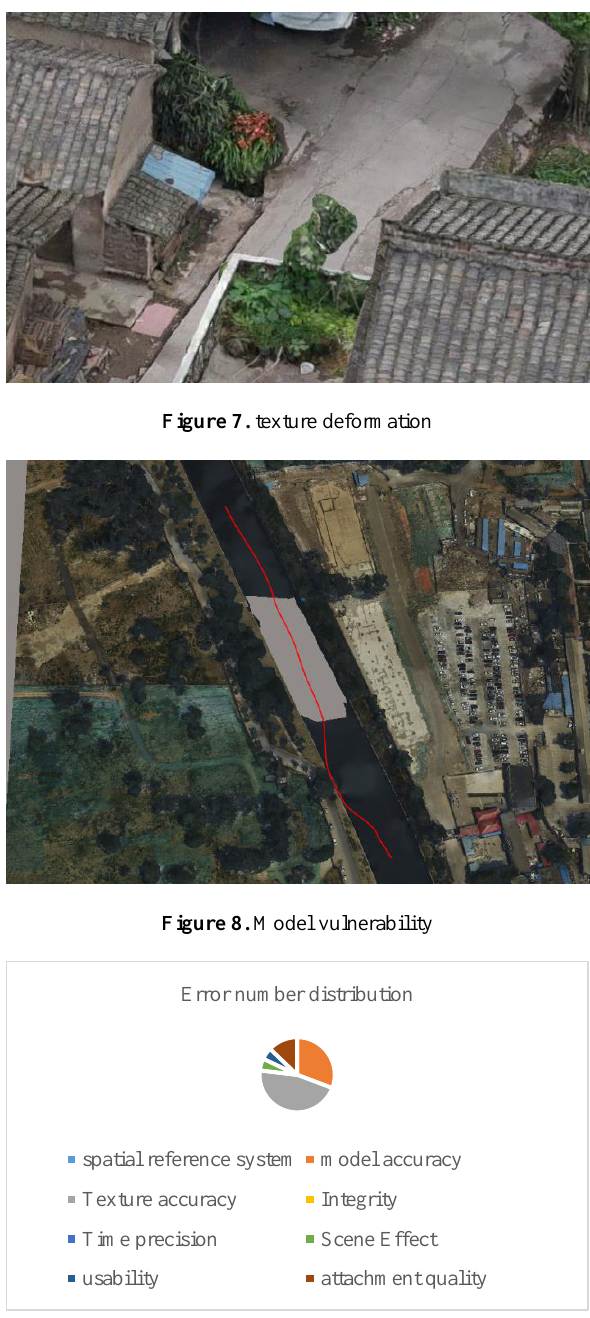
Figure 9. elevation error distribution